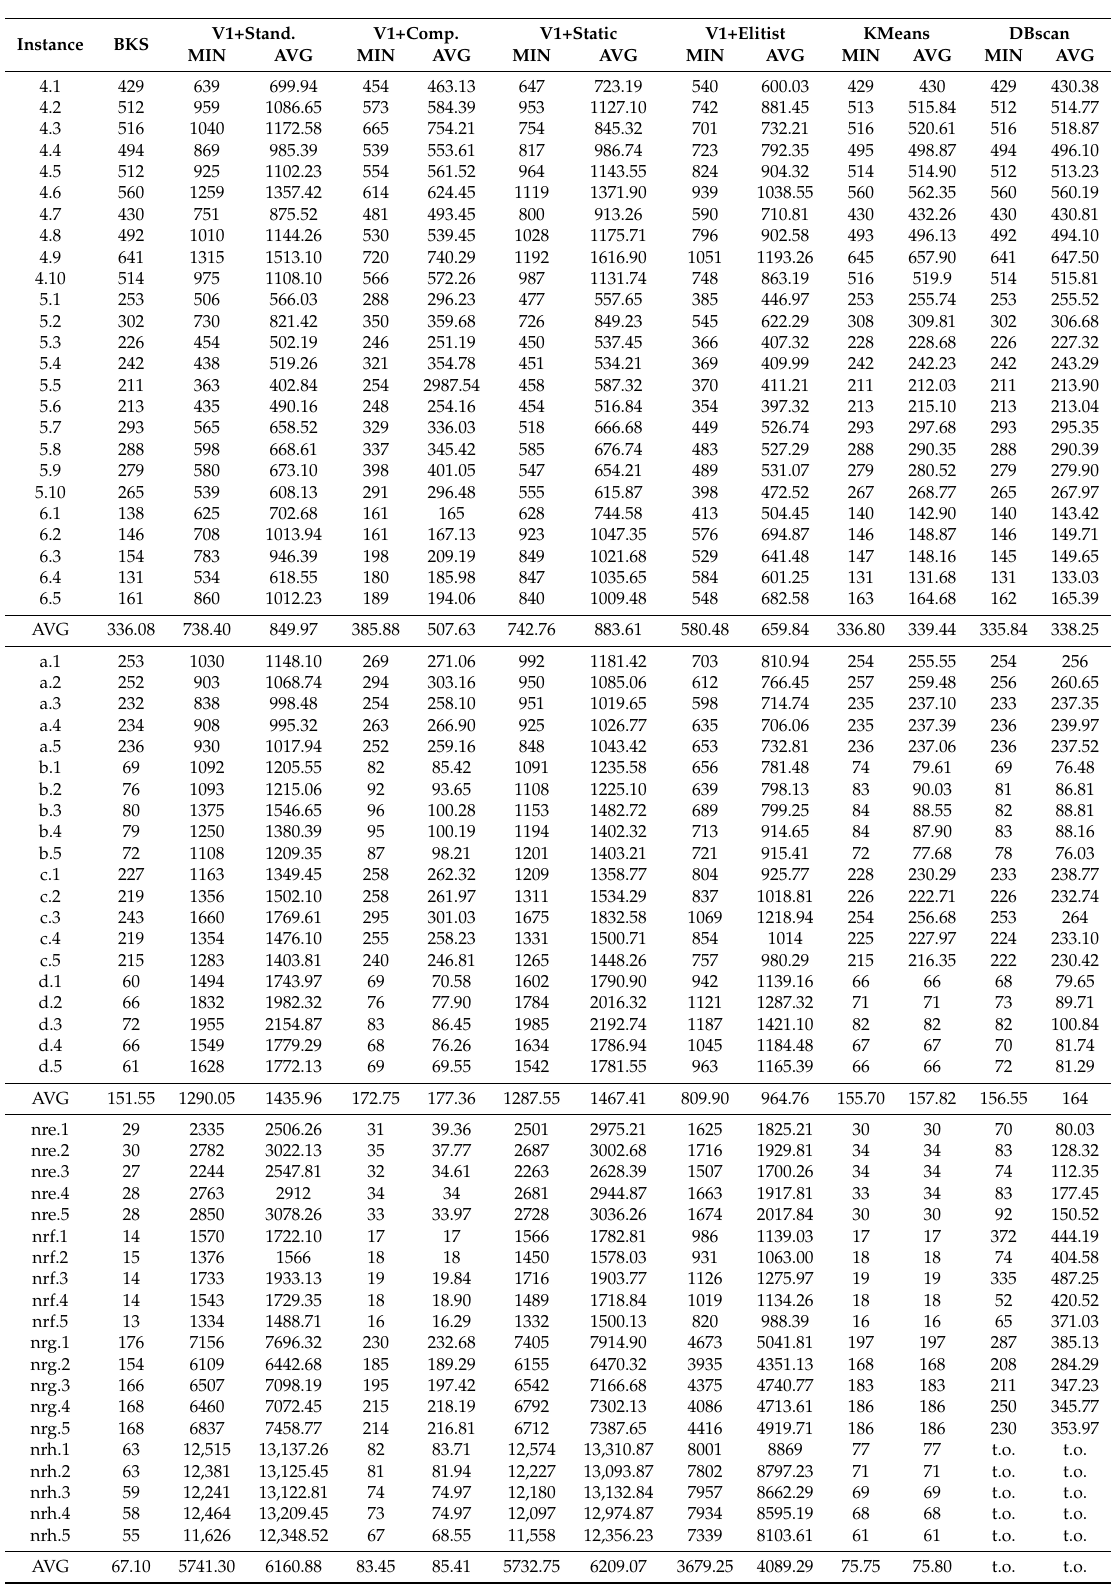
Table A5. CSA/SCP—VShape 1—Two-steps vs. KMeans vs. DBscan (t.o = time